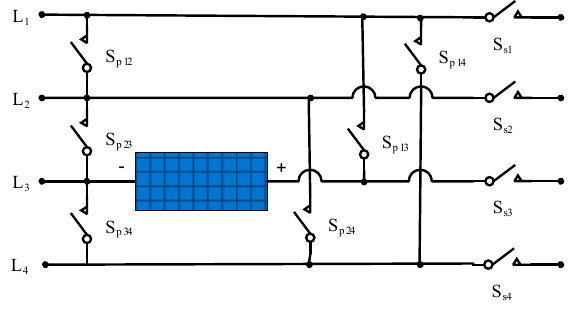
Figure 1. Optimised topology structure proposed in [22], IET: 2018.